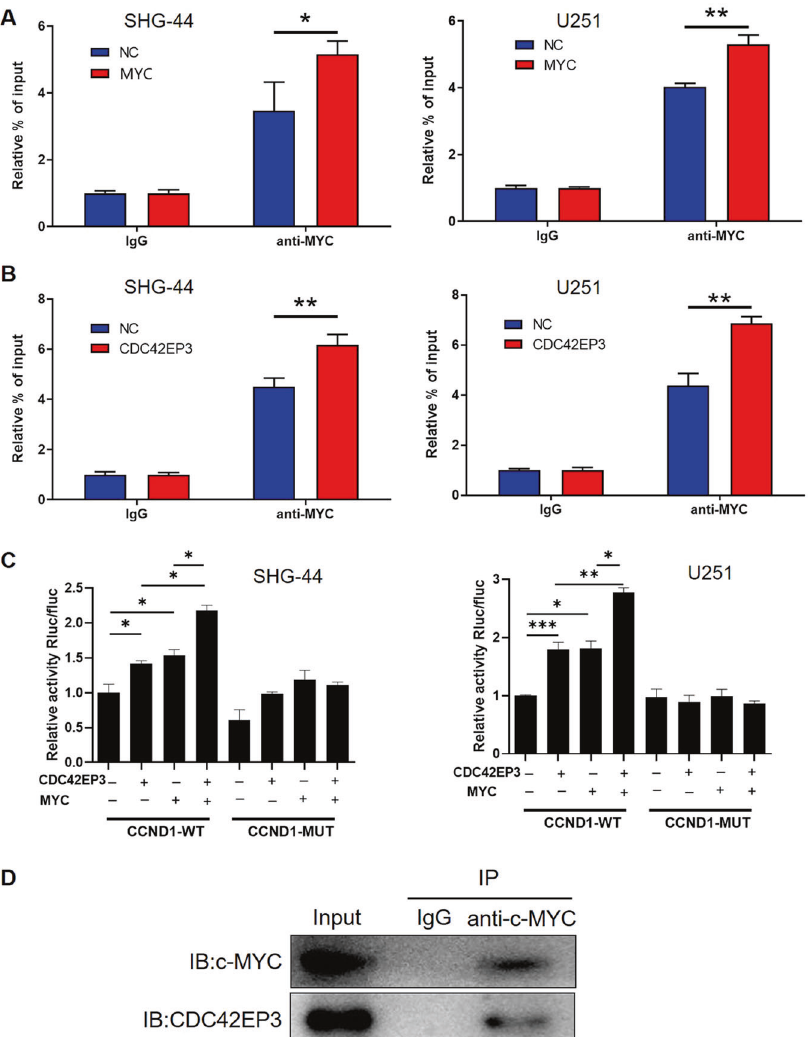
change >1.3 and the FDR <0.05. B CDC42EP3-related interaction network and signaling pathways identi fi ed by IPA in SHG-44 cells. C The changes in the mRNA expression of 20 DEGs following CDC42EP3 depletion in SHG-44 cells were identi fi ed by qPCR. All relative mRNA levels of the downstream genes of CDC42EP3 were signi fi cantly different between two groups (shCtrl vs. shCDC42EP3). D The changes in the expression of several downstream targets following CDC42EP3 depletion in SHG-44 cells identi fi ed by WB. E The differential expression of CCND1 in glioma tissues and normal brain tissues was analyzed based on the data collected from TCGA database. F ROC curve analyses and AUC values for CCND1 in glioma and normal brain tissues. Data were presented by mean with SD ( n ≥ 3). ** P <